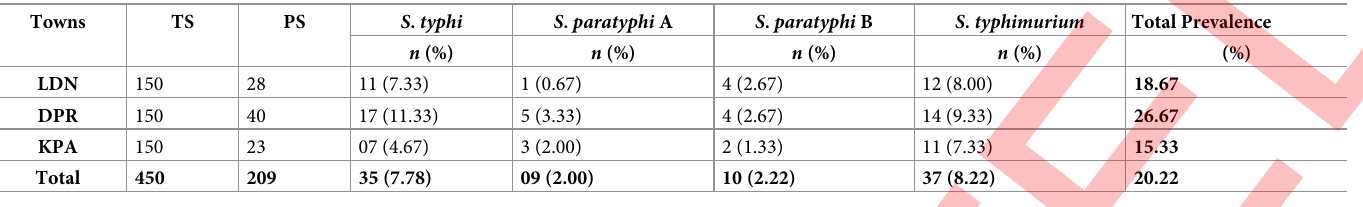
Towns; LDN: Lodhran, DPR: Dunya Pur, KPA: Kehror Pakka. TS; Total number of samples, PS; Total number of positive sample, n = Number of positive samples of respective spp; χ 2(df = 4, α = 0.05) = 3.3584 at p value = 0.1865 for towns; χ 2(df = 3, α = 0.05) = 6.8869 at p value = 0.0756 for Salmonella spp.